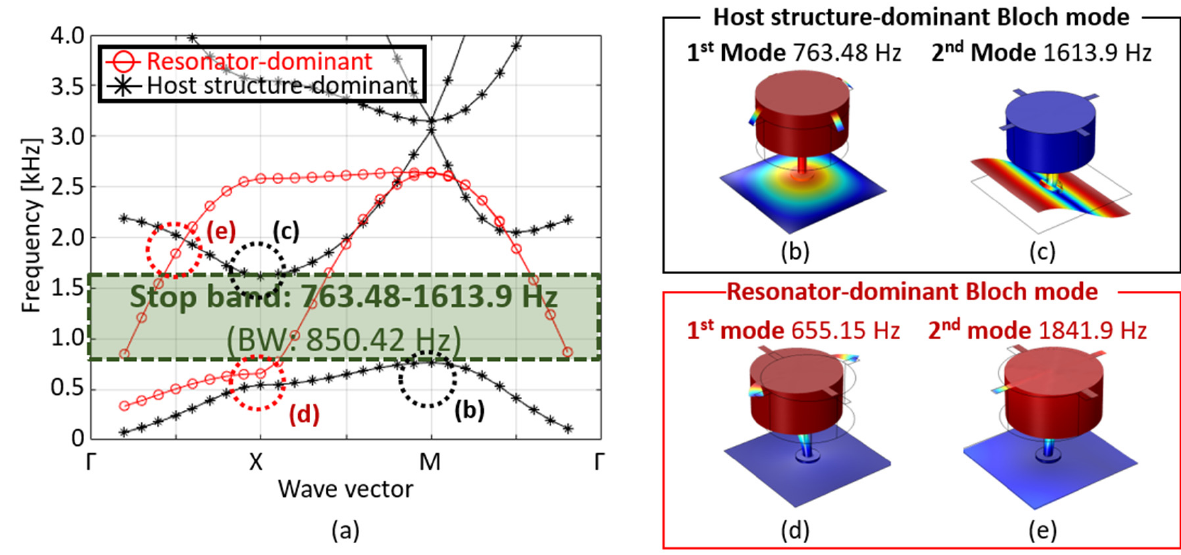
Figure 4. Dispersion diagram of the interconnected metamaterial: ( a ) stopband plot with host structure dominant (black star line) and resonator dominant (red circle line) bands; ( b ) and ( c ) are host structure dominant Bloch modes; ( d ) and ( e ) are resonator dominant Bloch modes.